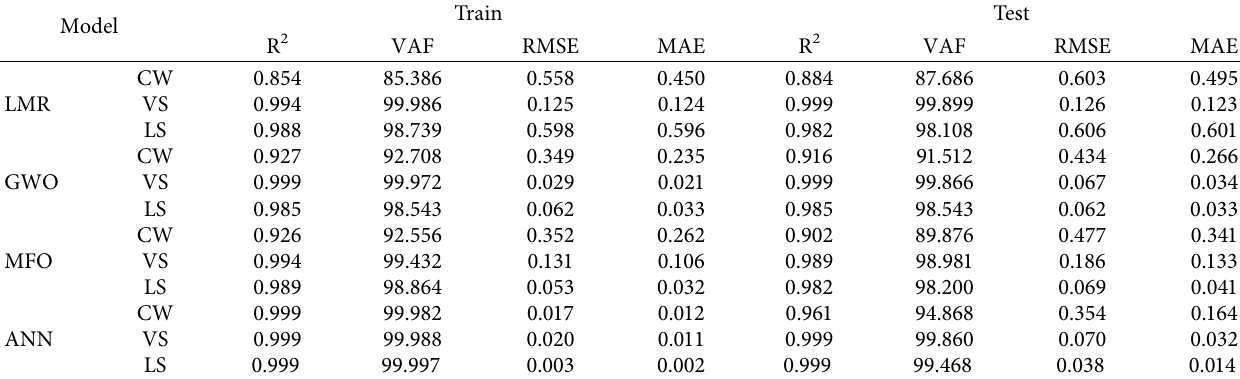
Table 11: The best predicted values of R 2 , VAF, RMSE, and MAE for predict CW, VS, and